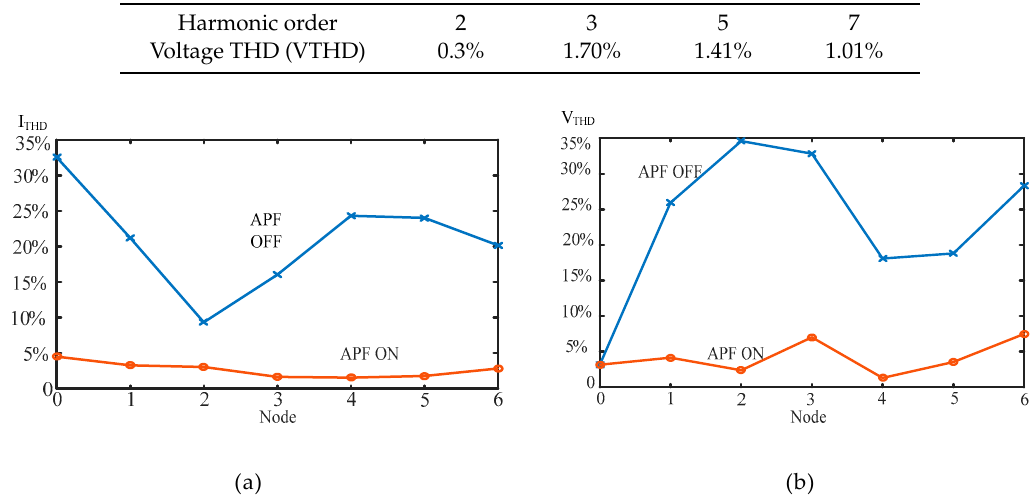
Figure 8. THD with nonlinear load and background harmonic: ( a ) current, and ( b )voltage.